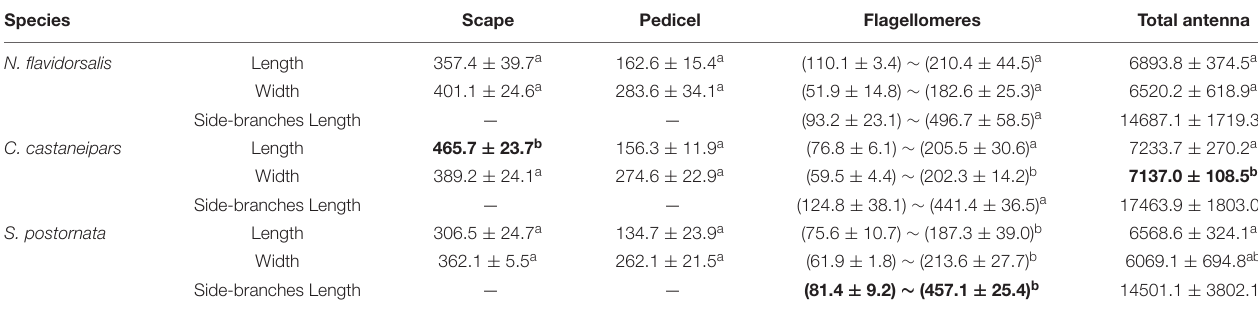
TABLE 1 | Morphological measurements (mean ± SE, µ m) of three parts of antenna in three species of male Limacodidae moths. Species Scape Pedicel Flagellomeres Total antenna